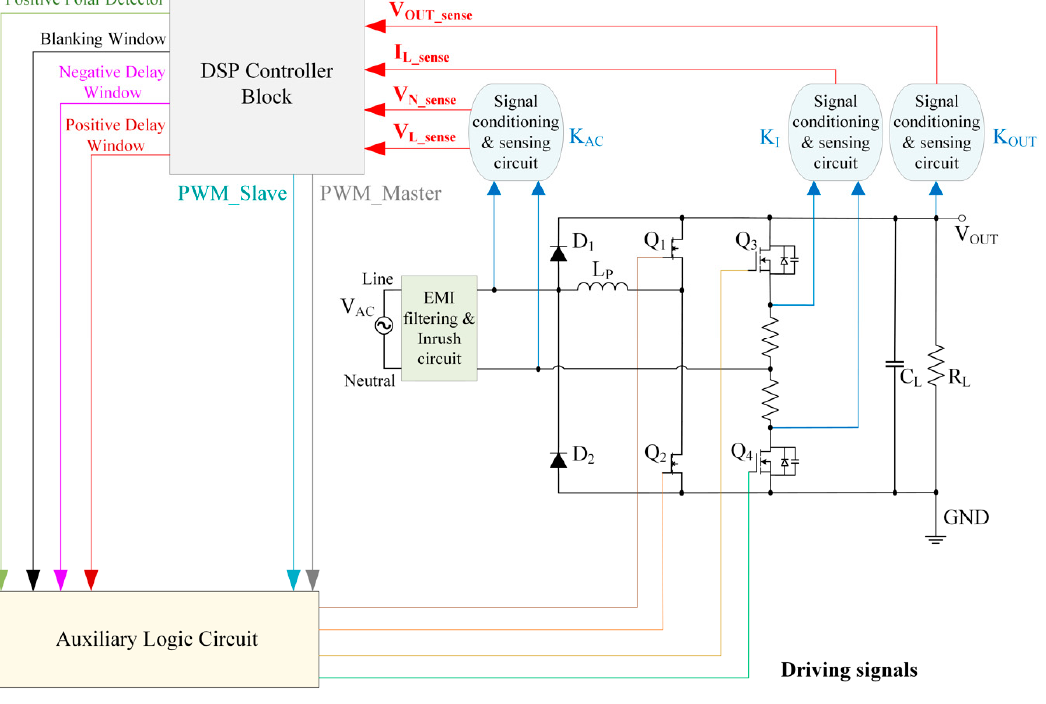
Figure 2. Simplified block diagram of the proposed structure.